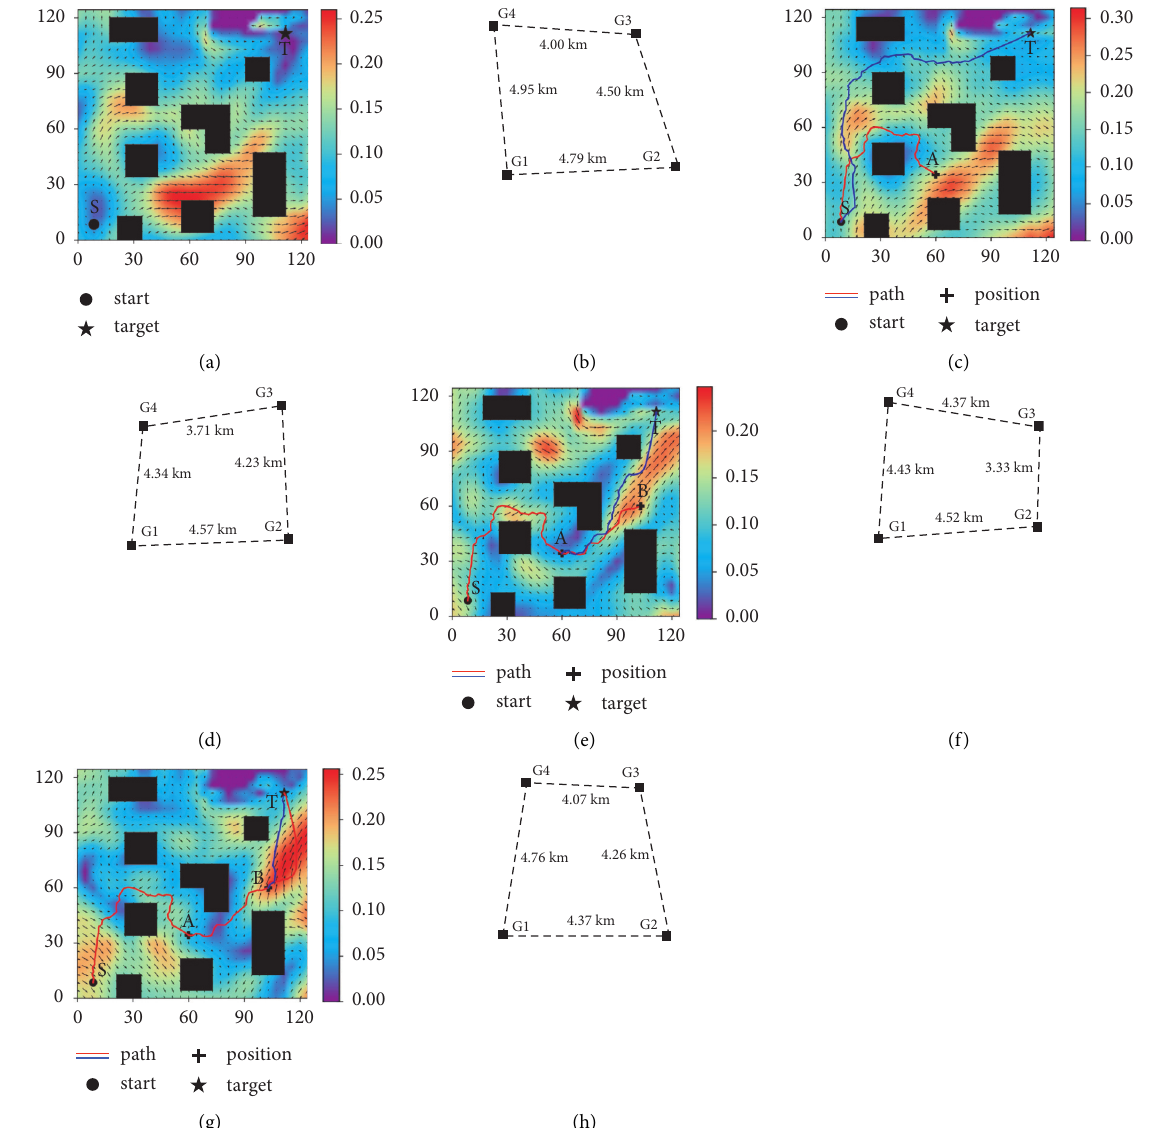
Figure 10: The UGs formation path planning on128 × 128 time-varying ocean maps and the formation shape of UGs in different cycles. (a) State S. (b) Formation Shape in S. (c) State A. (d) Formation Shape in A. (e) State B. (f) Formation Shape in B. (g) State T. (h) Formation Shape in